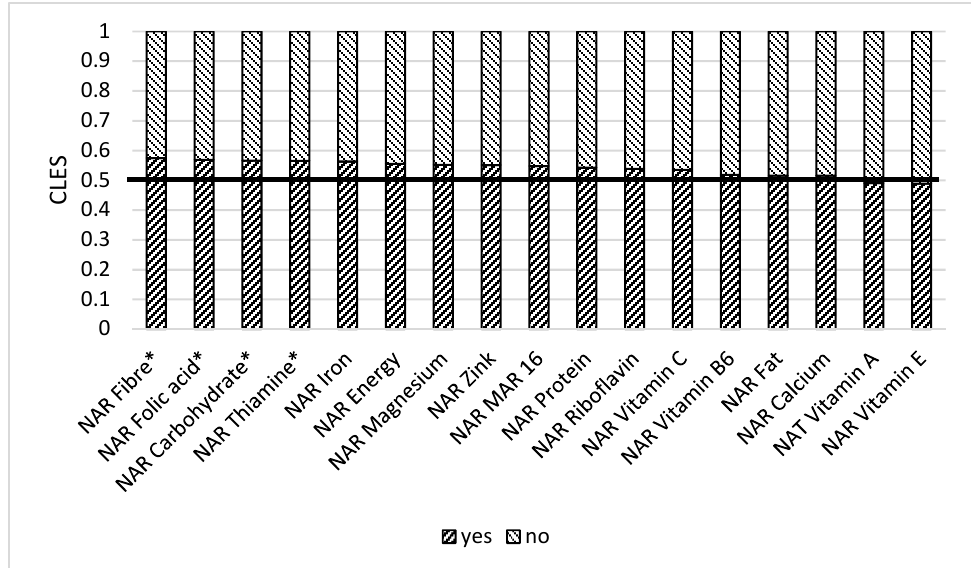
Figure 10. Comparison of NAR for 16 nutrients with getting remittances or not . NAR—nutrient adequacy ratio; MAR 16—mean nutrient adequacy ratio for 16 nutrients. CLES—common language effect size; Wilcoxon p -value; * p -value < 0.05.